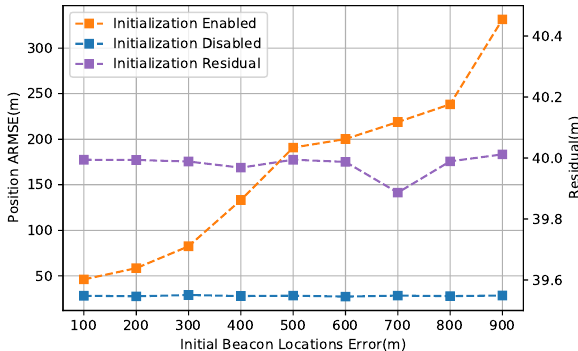
Figure 12. Comparison of the position estimation accuracy from different numbers of beacons.